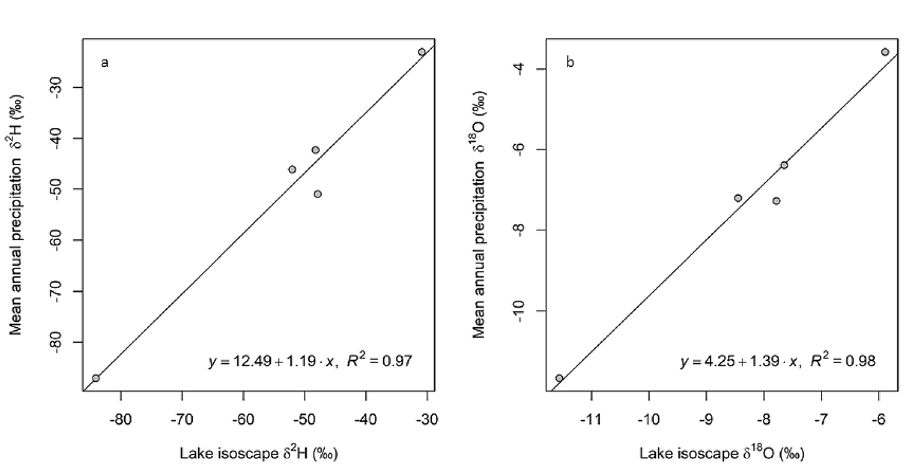
Figure 4. δ 2 H values from GNIP data plotted vs. model predicted δ 2 H values ( a ), δ 18 O values from GNIP data plotted vs. model predicted δ 18 O values ( b